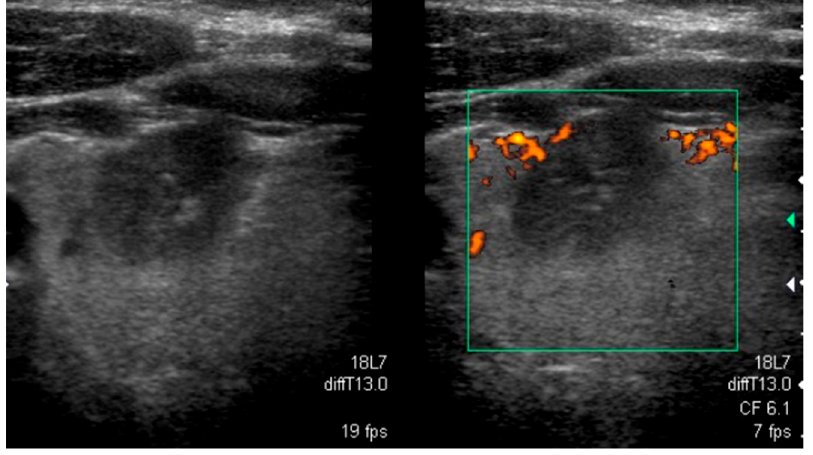
Figure 1. Typical sonographic pattern of a BRAF V600E -positive papillary thyroid carcinoma hypoechoic lesion with poorly defined irregular margins and microcalcifications.